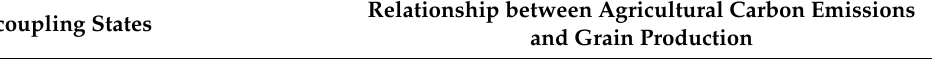
Table 2. Degrees of decoupling